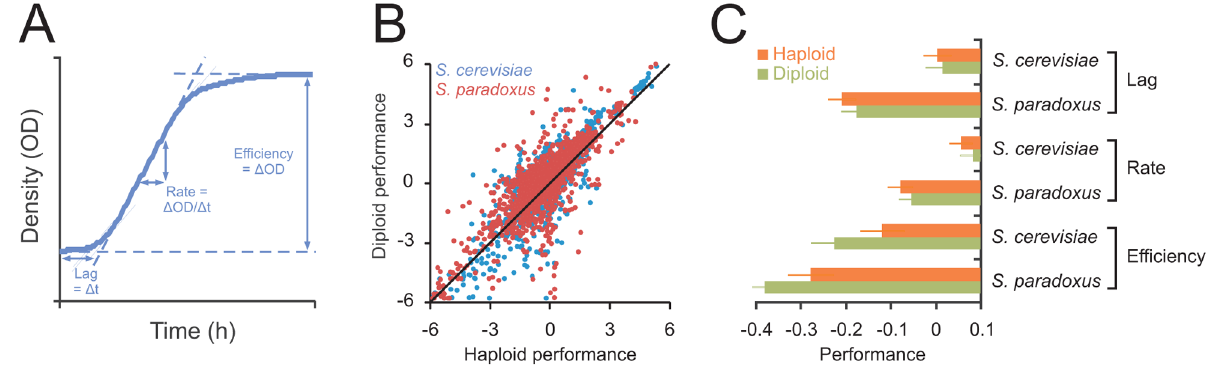
Figure 1. Ploidy–environment interactions are the rule rather than the exception in yeast and favor haploidy and diploidy equally. A) The mitotic fitness components lag (time to initiate proliferation), rate (population doubling time) and efficiency (total change in population density) of asexual reproduction were extracted from high density growth curves of 24 S. cerevisiae and 27 S. paradoxus strains cultivated as haploids (n=4) and diploids (n=2) in an array of environmental contexts. Performance was log(2) transformed and normalized to that of the universal reference strain S288c, providing relative performance measures. B) The performances of haploids and diploids were compared over all species, strains, mitotic fitness components and environments. Line indicates the 1:1 correlation. C) The performance of haploids and diploids over all strains and environments. Note that performance is on a log(2) scale. No significant difference between the two ploidy states (FDR, a =0.05) were found. Error bars represent